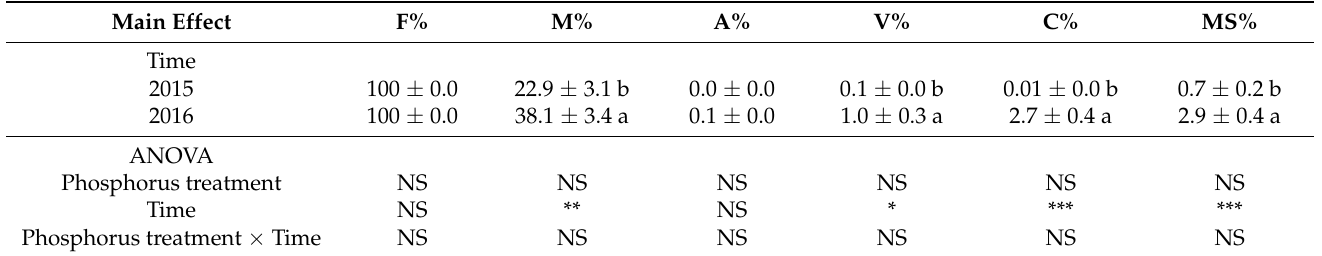
Table 3. Frequency (F%) and intensity (M%) of arbuscular mycorrhizal colonization, with frequencies of arbuscules (A%), vesicles (V%), coils (C%) and microsclerotia (MS%) in roots of inoculated Ajania plants in 2015 and 2016. Data are presented as means ± standard errors (n =